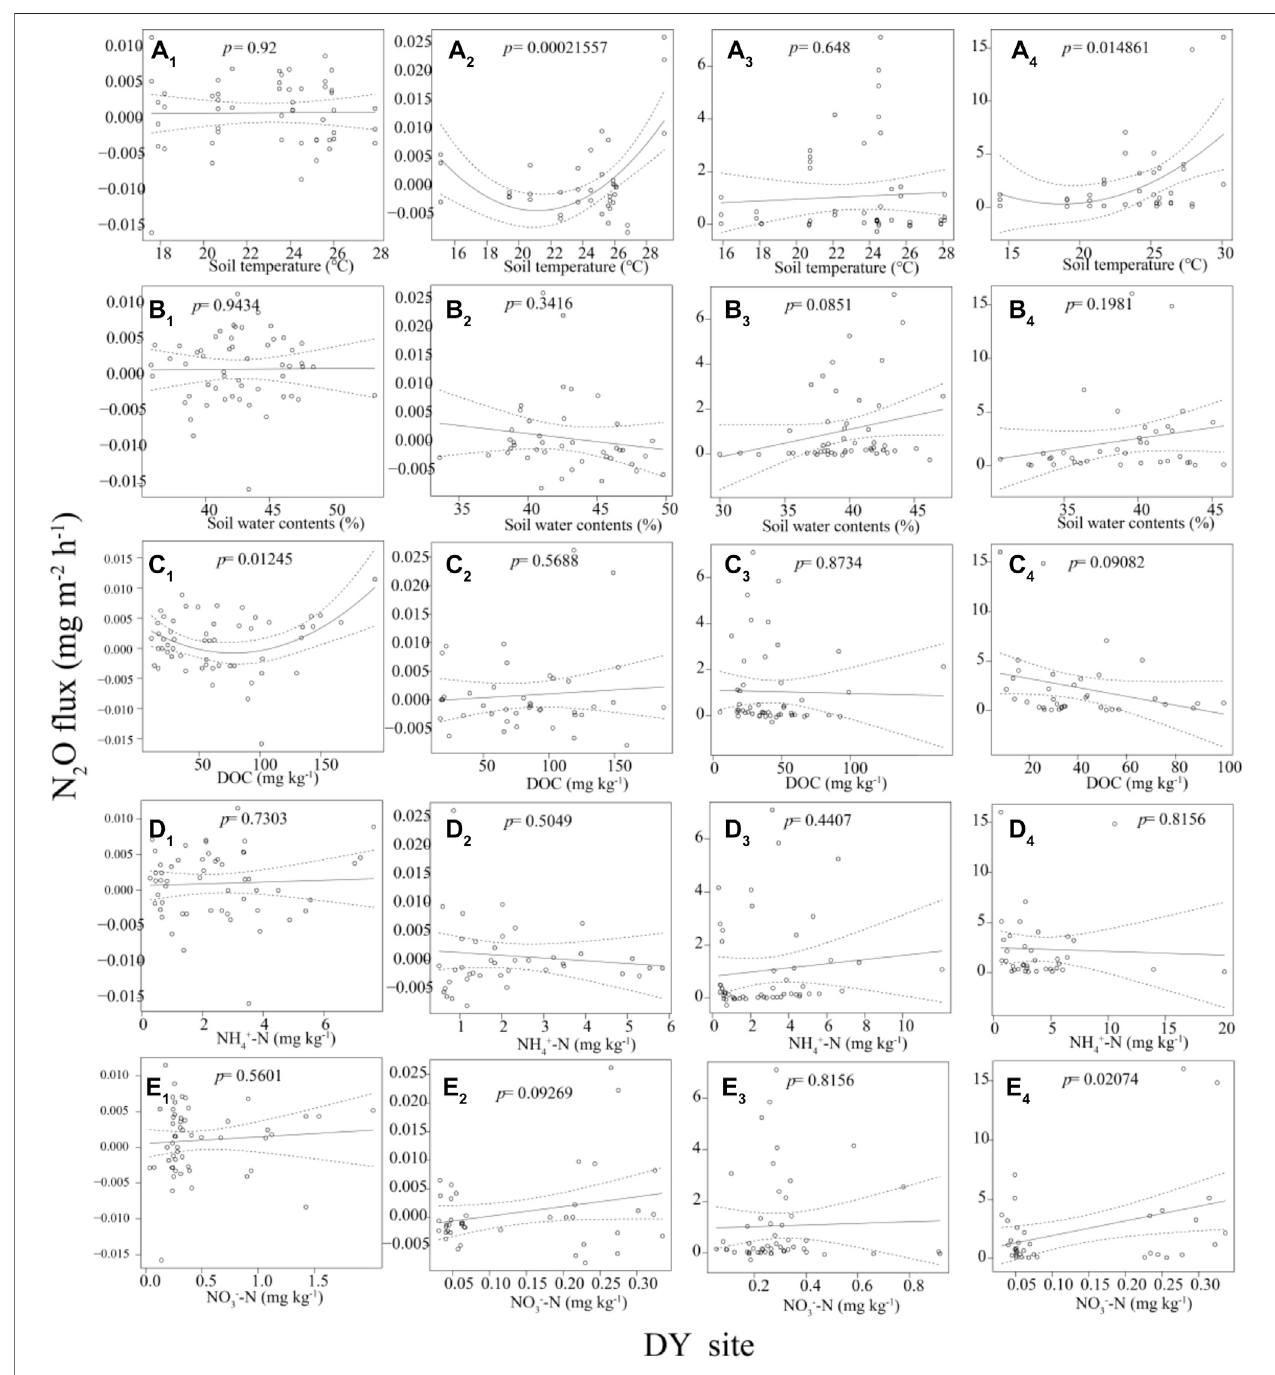
FIGURE 4 | A 1 , B 1 , C 1 , D 1 , and E 1 means the relationships between N 2 O fl uxes and soil temperature, soil water content, DOC contents, NH 4+ -N contents, and NO 3 − -N contentsintheCWR 0 ,respectively.A 2 ,B 2 ,C 2 ,D 2 ,andE 1 meanstherelationshipsbetweenN 2 O fl uxesandsoiltemperature,soilwatercontent,DOCcontents, NH 4+ -N contents, and NO 3 − -N contents in the CWR 1 , respectively. A 3 , B 3 , C 3 , D 3 , and E 3 means the relationships between N 2 O fl uxes and soil temperature, soil water content,DOCcontents,NH 4+ -Ncontents,andNO 3 − -NcontentsintheNWR 0 ,respectively.A 4 ,B 4 ,C 4 ,D 4 ,andE 4 meanstherelationshipsbetweenN 2 O fl uxesand soil temperature, soil water content, DOC contents, NH 4 + -N contents, and NO 3 − -N contents in the NWR 1 , respectively.